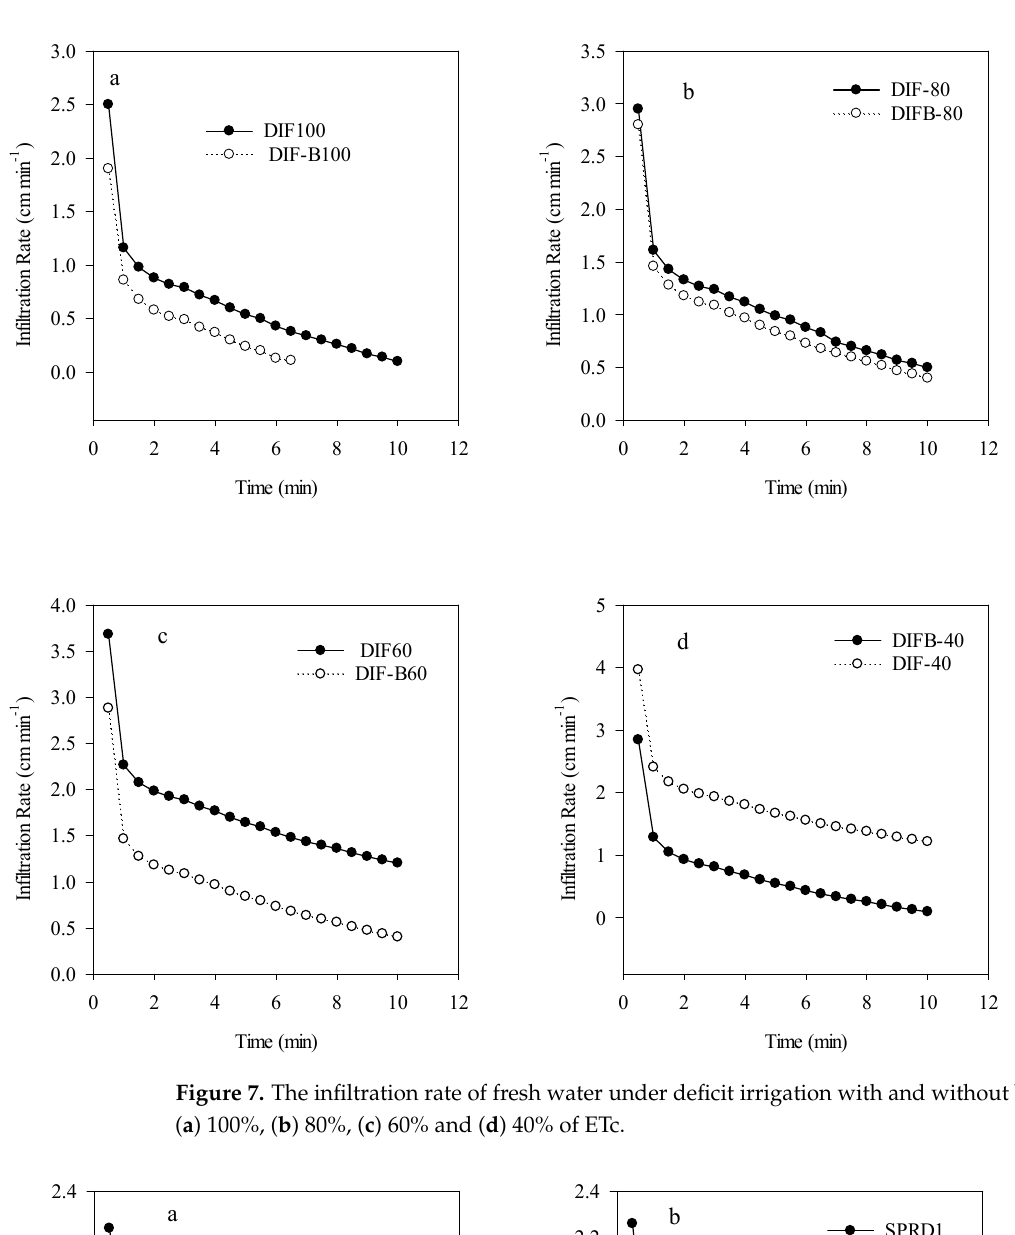
Figure 7. The infiltration rate of fresh water under deficit irrigation with and without biochar, where ( a ) 100%, ( b ) 80%, ( c ) 60%, and ( d ) 40% of ETc.